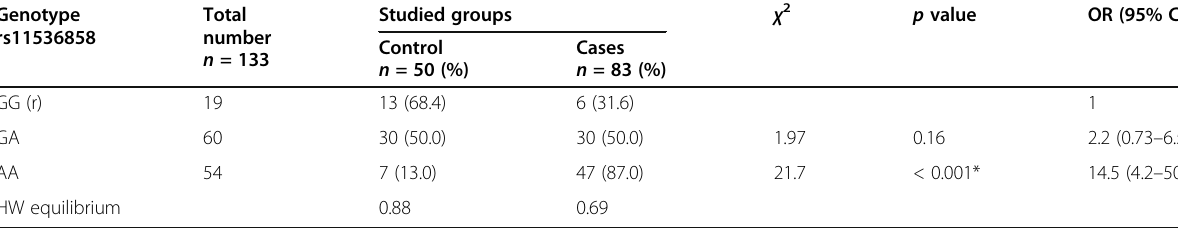
Table 6 rs11536858 Genotype distribution between cases and control Genotype rs11536858